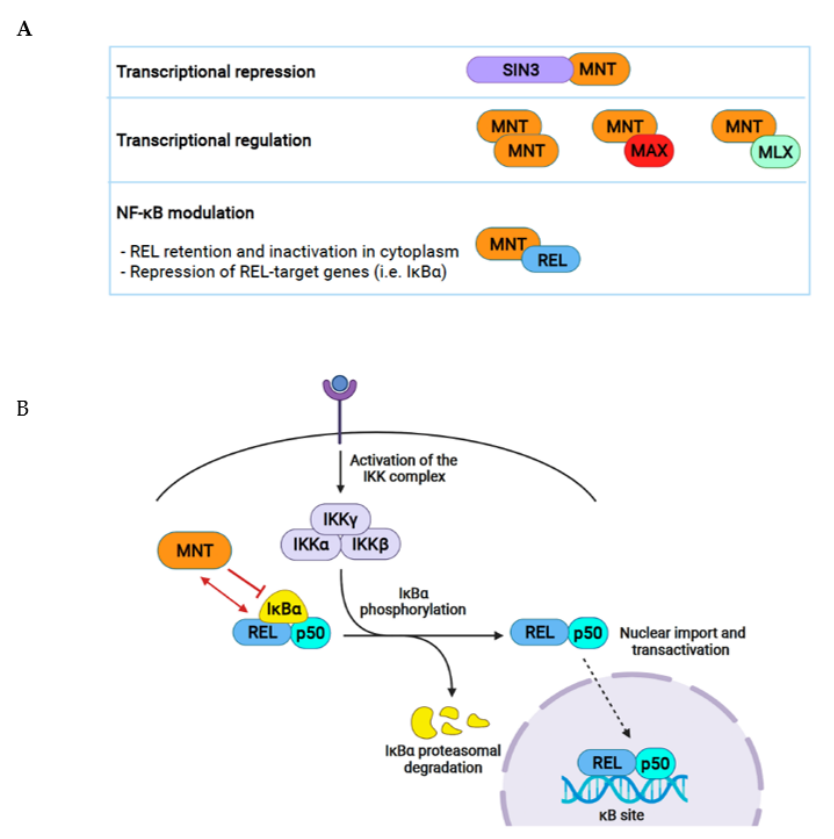
Figure 4. MNT functional interactions. ( A ) MNT represses transcription through SIN3, which recruits a HDAC complex and turns DNA into a closed conformation. MNT homodimers and MNT–MAX and MNT–MLX heterodimers regulate transcription by binding DNA at E-boxes. MNT–REL interaction results in NF- κB reg ulation by retaining REL dimers inactive in the cytoplasm and by repressing REL target genes that would usually be activated by REL. ( B ) Once the cell receives an NF- κB activation signal, the IKK complex is activated and is able to phosphorylate IκBα, whic h is bound to REL- p50 dimers in the cytoplasm. This phosphorylation targets IκBα for ubiquitination and posterior proteasomal degra- dation. Finally, the REL-p50 dimers are free to translocate into the nucleus and regulate their target genes by binding to κB sites on the DNA. MNT forms complexes with REL and inhibits its functions.